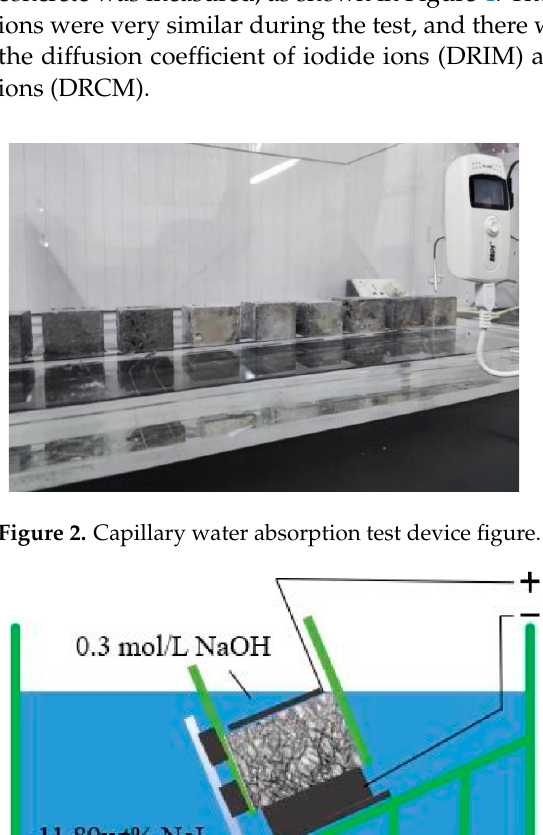
Figure 3. RIM test setup.